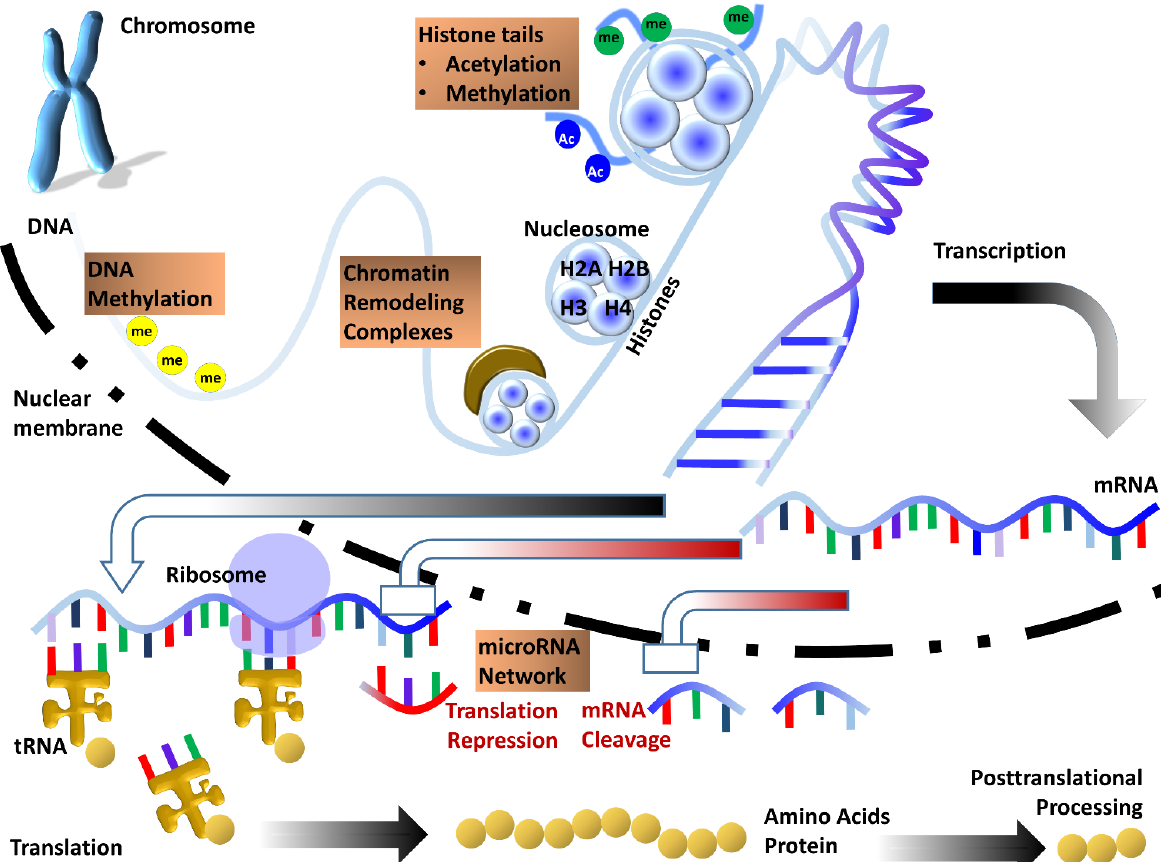
Figure 1. Sketch illustrating the multi-layered control of gene expression by various epigenetic processes. DNA is subject to direct chemical modification by addition or removal of methyl groups at cytosine bases. Epigenetic processes regulating gene expression at a higher level of DNA compaction include histone tail modifications and control of chromatin accessibility by ATP dependent chromatin remodeling complexes. Once transcribed, mRNA can be further regulated by the microRNA network which provides an additional layer of epigenetic control of gene expression. Together, these epigenetic mechanisms function in concert to help fine-tune gene expression within the